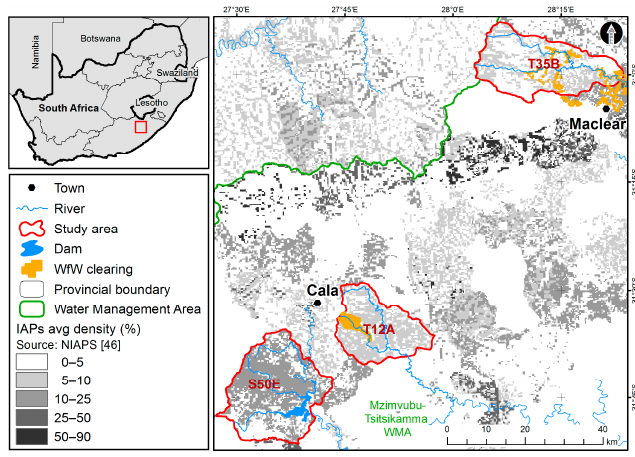
Figure 1. Three study sites: S50E, T12A and T35B. WfW, Working for Water; IAP, invasive alien plant, NIAPS, National Invasive Alien Plant Survey [46], WMA, water management area.